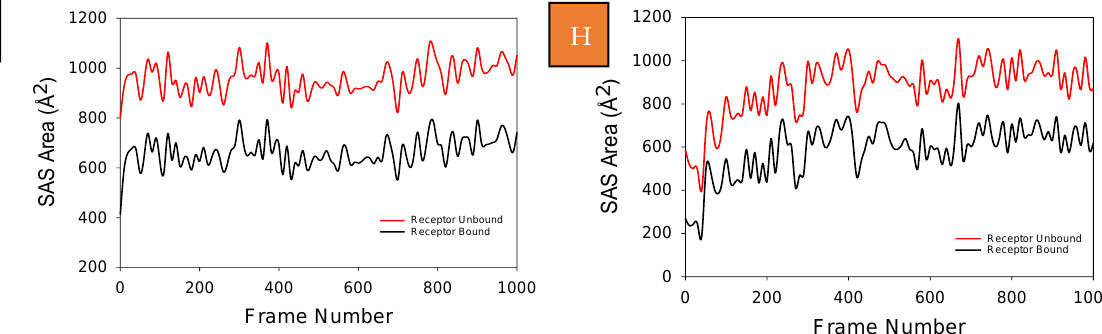
Figure 4. MD simulation analysis of 200 ns trajectories of ( A ) C α backbone RMSD of 3FJZ- glyphosate (red), 3FJZ- α -phellandrene (blue), 3FJZ- β -phellandrene (purple), and 3FJZ- β -myrcene (black) ( B ) RMSF of C α backbone of 3FJZ-glyphosate (red), 3FJZ- α -phellandrene (blue), 3FJZ- β - phellandrene (purple), and 3FJZ- β -myrcene (black) ( C ) C α backbone radius of gyration (Rg) of 13FJZ- glyphosate (red), 3FJZ- α -phellandrene (blue), 3FJZ- β -phellandrene (purple), and 3FJZ- β -myrcene (black). ( D ) Formation of hydrogen bonds in 3FJZ-glyphosate (red), 3FJZ- α -phellandrene (blue), 3FJZ- β -phellandrene (purple), and 3FJZ- β -myrcene (black). Solvent accessible surface area plots of ( E ) 3FJZ-glyphosate, ( F ) 3FJZ- α -phellandrene, ( G ) 3FJZ- β -phellandrene, and ( H ) 3FJZ- β -myrcene.